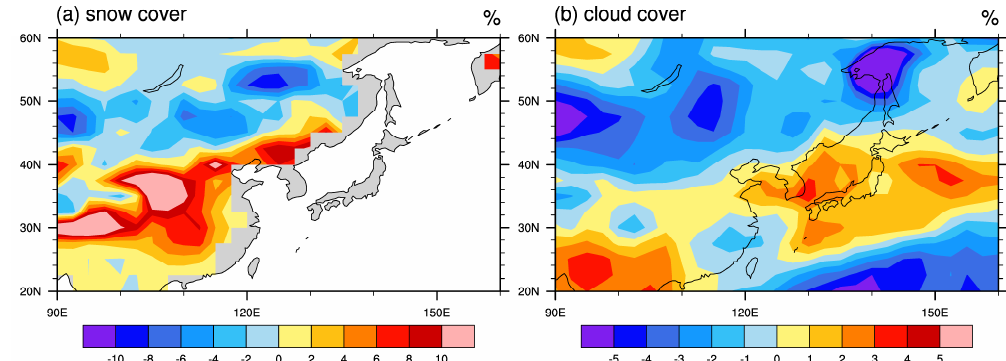
Figure 8. Geographical distributions of the differences in ( a ) snow cover and ( b ) cloud cover between the G4cdnc and RCP4.5 simulations during DJF season in the progress period over East Asia. The results are derived from two models of CanESM2 and MIROC-ESM.